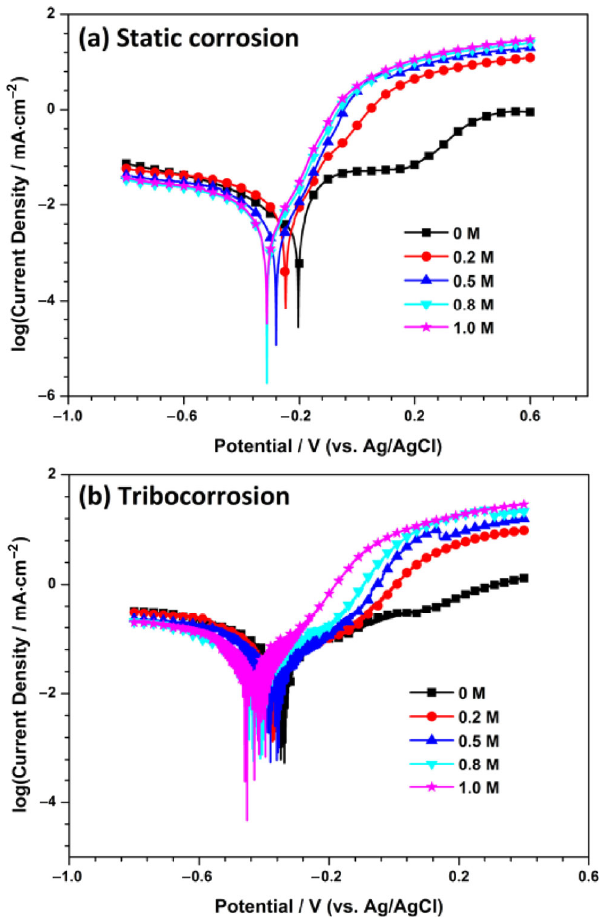
Fig. 3 Potentiodynamic polarization curves for NAB alloy under (a) static corrosion and (b) tribocorrosion conditions in seawater with different halide-ion